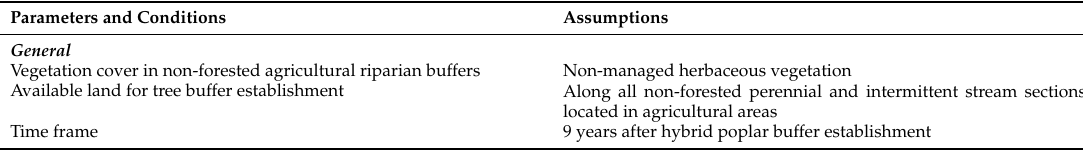
Table 5. Overview of assumptions made for the extrapolation of ecosystem services provided by hybrid poplar buffers at the watershed